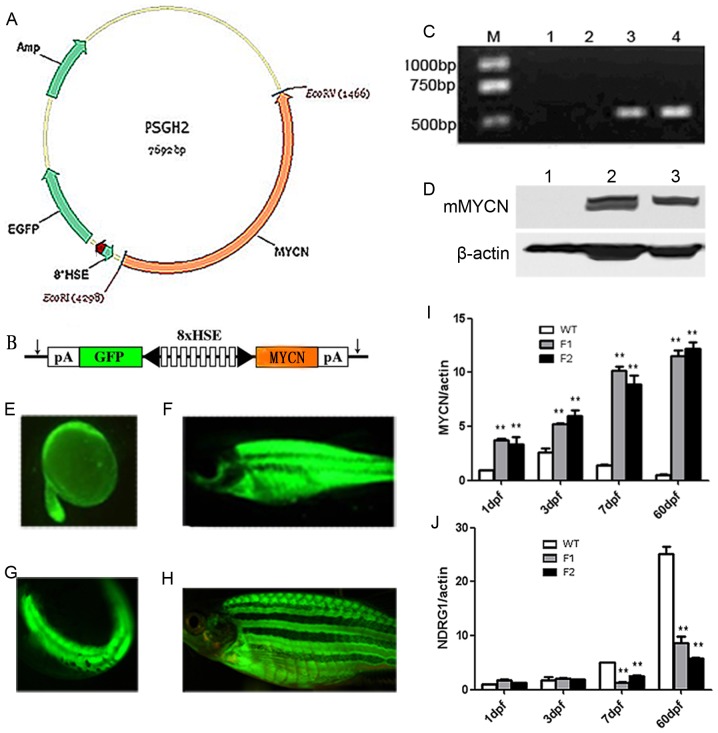
Generation of Tg(MYCN:HSE:EGFP) zebrafish line.(A) Schematic diagram of the structure of PSGH2/MYCN recombinant plasmid. A mouse-MYCN fragment was cloned from HA-MYCN plasmid and inserted into the EcoRI and EcoRV sites of the PSGH2 vector. (B) A schematic presentation of the heat shock element (HSE) promoter. The artificial promoter contains eight multimerized heat shock elements flanked by two minimal promoters in opposed orientation (black arrowhead). EGFP and MYCN are expressed from the bidirectional promoter. The vector is flanked by I-SceI meganuclease sites (arrows). pA, SV40 polyadenylation signal. (C) Transgenic verification by qRT-PCR: M: TAKARA DL2000 marker; lane 1: Blank control (double distilled water); lane 2 and 3: WT and Tg F1 generation embryos at 3 dpf, respectively; lane 4: Positive control (plasmid). (D) Transgenic verification by westernblot: lane 1: WT embryo at 3 dpf; lane 2 and 3: Tg F1 and F2 generation embryos at 3 dpf, respectively. (E–F) EGFP (+) F0 mosaic zebrafish at 24 hours (×50) and 60 days post microinjection (×7.5). (G–H) EGFP (+) F1 Tg zebrafish at 24 hpf (×50) and 60 dpf (×10). (I) Expression of total MYCN (murine exogenous and zebrafish endogenous expression), which was increased gradually in Tg F1, F2 generation fish comparing with that in WT. (J) Expression of NDRG1, which is negative controlled by MYCN in human, was keeping a low lever in Tg F1 and F2 generation. **, P<0.01